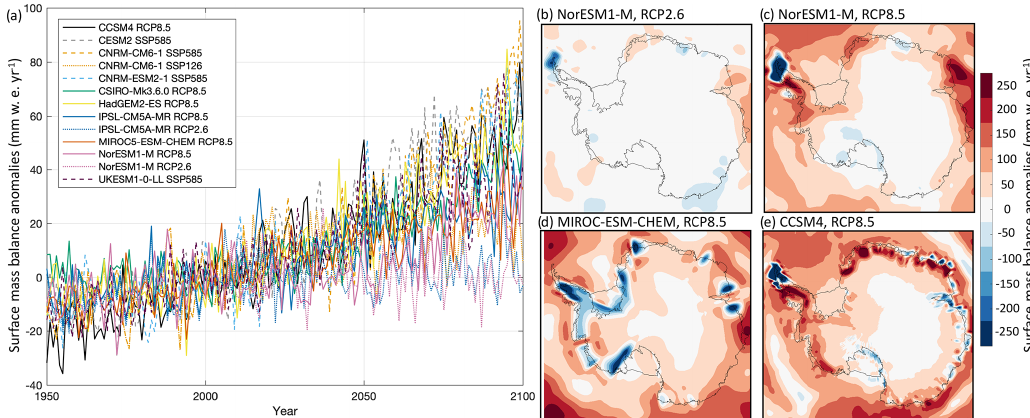
Figure 3. Surface mass balance anomalies (mmw.e.yr − 1 ) over the Antarctic ice sheet under the RCP2.6, RCP8.5, SSP1-2.6, and SSP5-8.5 scenarios. (a) Time series of mean surface mass balance anomaly from 1950 to 2100 for all AOGCMs and scenarios selected and (b– e) mean surface mass balance anomaly over the time period 2081–2100 for (b) NorESM1-M under RCP2.6, (c) NorESM1-M under RCP8.5, (d) MIROC-ESM-CHEM under RCP8.5, and (e) CCSM4 under